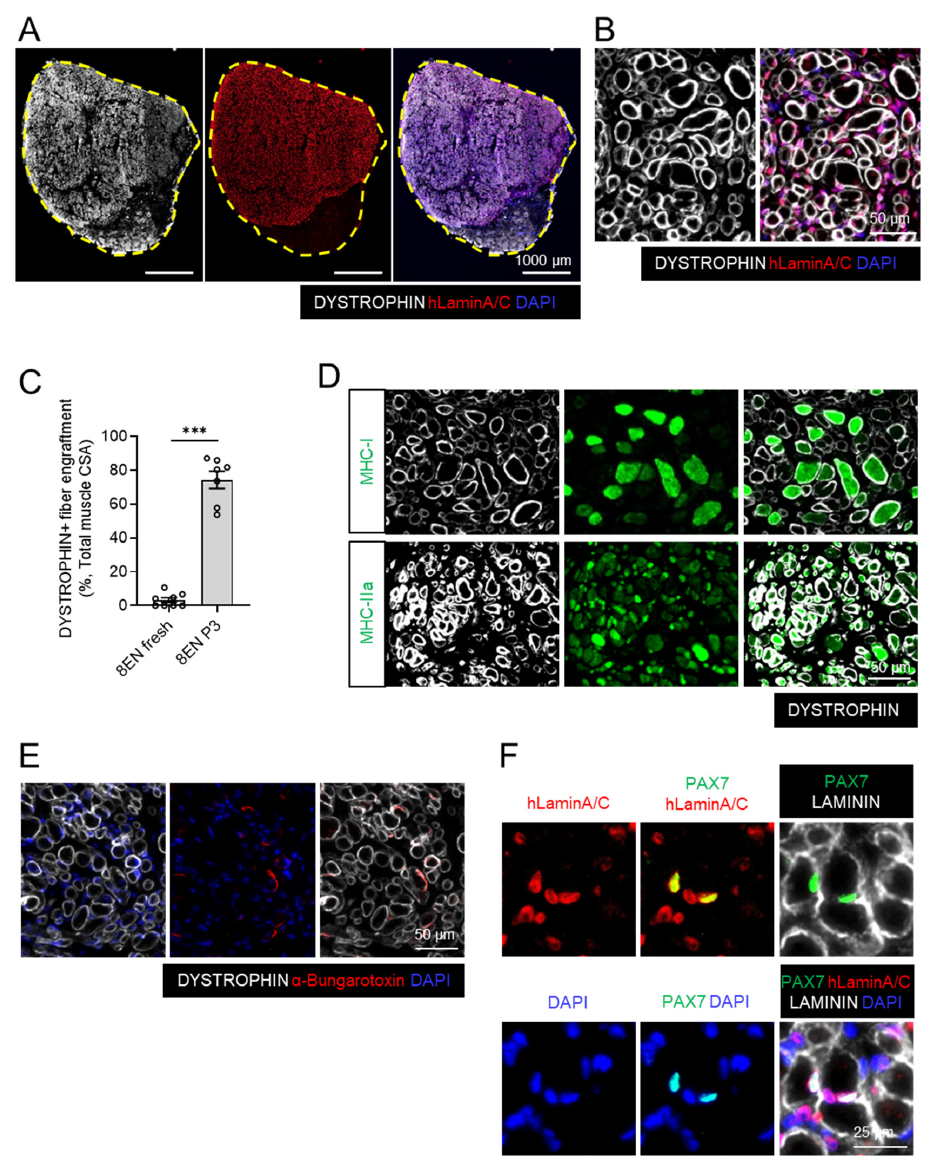
Figure 4. Passaged 8EN skeletal myogenic progenitors engrafted to form new muscle fibers and to reconstitute the muscle stem cell pool after transplantation. Passage 3 8EN cells engrafted and formed new dystrophin + fibers: ( A ) the whole TA muscle (scale bar = 1000 μ m), ( B ) magnified image (scale bar = 50 μ m). Human lamin A/C expression in cell nuclei indicated human origins, i.e., donor cell-derived cells. ( C ) Quantification of fiber engraftment from freshly-isolated vs. passage 3 8EN cell transplantation (mean ± SEM, 7–8 biological replicates, *** p < 0.001). In both cases, 100,000 cells were transplanted. ( D ) Newly formed dystrophin + fibers expressed adult myosin isoforms MHC-I and MHC-IIa (scale bar = 50 μ m). ( E ) The proximity of α -bungarotoxin + post-synaptic staining and dystrophin + fibers suggested potential neuromuscular junctions and innervation (scale bar = 50 μ m). ( F ) Transplanted passaged 8EN cells repopulated the muscle stem cell pool, as evidenced by donor cell-derived human lamin A/C + PAX7 + cells residing in the fiber basal lamina (scale bar = 25 μ m). 8EN: CD82 + ERBB3 + NGFR + ; MHC: myosin heavy chain.